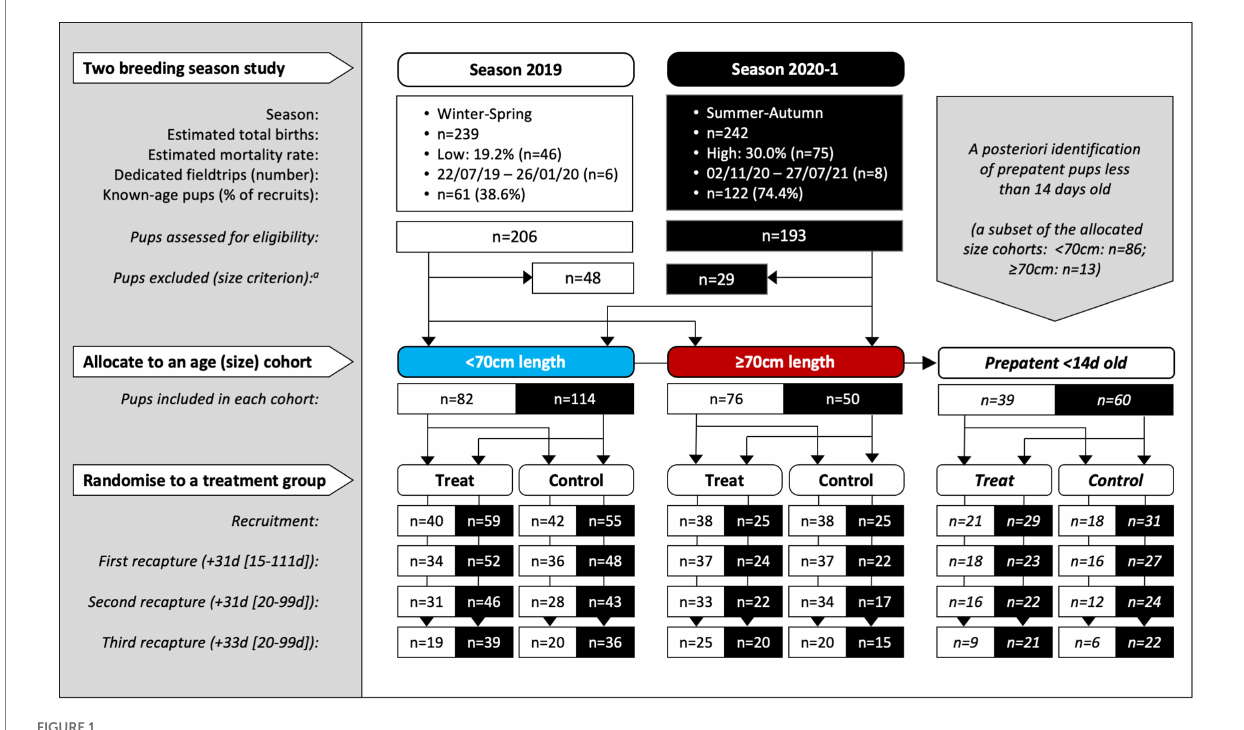
FIGURE 1 Study design for the two-season, randomized and controlled field-based trial of Australian sea lion pups at Seal Bay Conservation Park, Kangaroo Island, South Australia. Pups were recruited in consecutive breeding seasons (at all fieldtrips except the last of each season) and recaptured up to three times at subsequent monthly fieldtrips within the same season. Within two age cohorts (allocated by the standard length proxy to <70 and ≥ 70 cm) pups were randomized to treatment or control groups. A third cohort of prepatent pups <14 d old at recruitment was identified a posteriori . The median period length [and range] in days prior to recapture is shown for the combined age cohorts. a Sixteen pups ( n = 15, 2019; n = 1, 2020–1) >75 cm in standard length were recruited prior to implementing the 75 cm upper size restriction and were retained in the analysis.